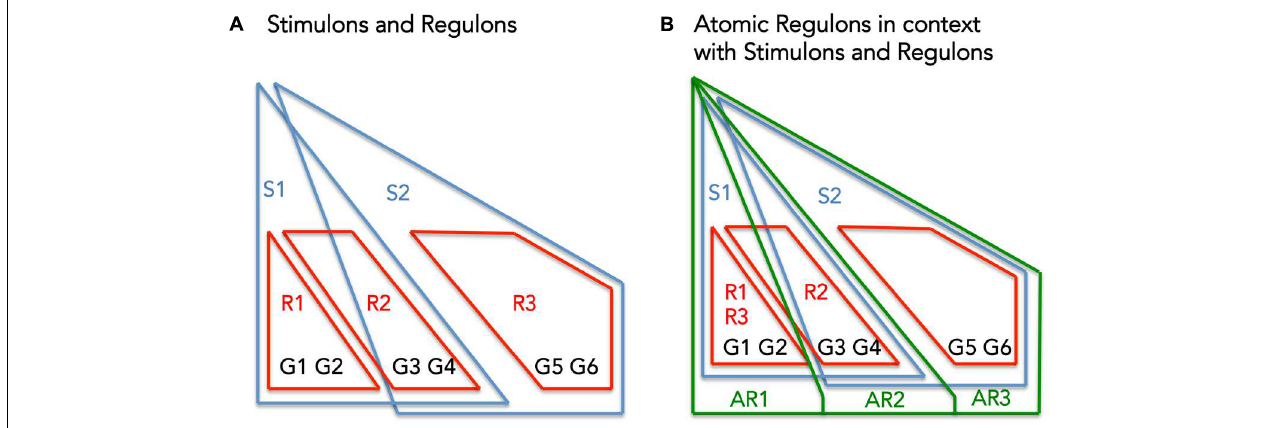
FIGURE 1 | The interplay between Stimulons, Regulons, and Atomic Regulons (ARs). (A) The representation features six genes (G1–G6), three regulators (R1–R3), and two stimuli (S1–S2). The red lines define the regulons and the blue lines define the stimulons. (B) Features in addition to (A) : the Atomic Regulons (AR1–AR3) in the representation as sets of genes that have identical binary expression profiles.